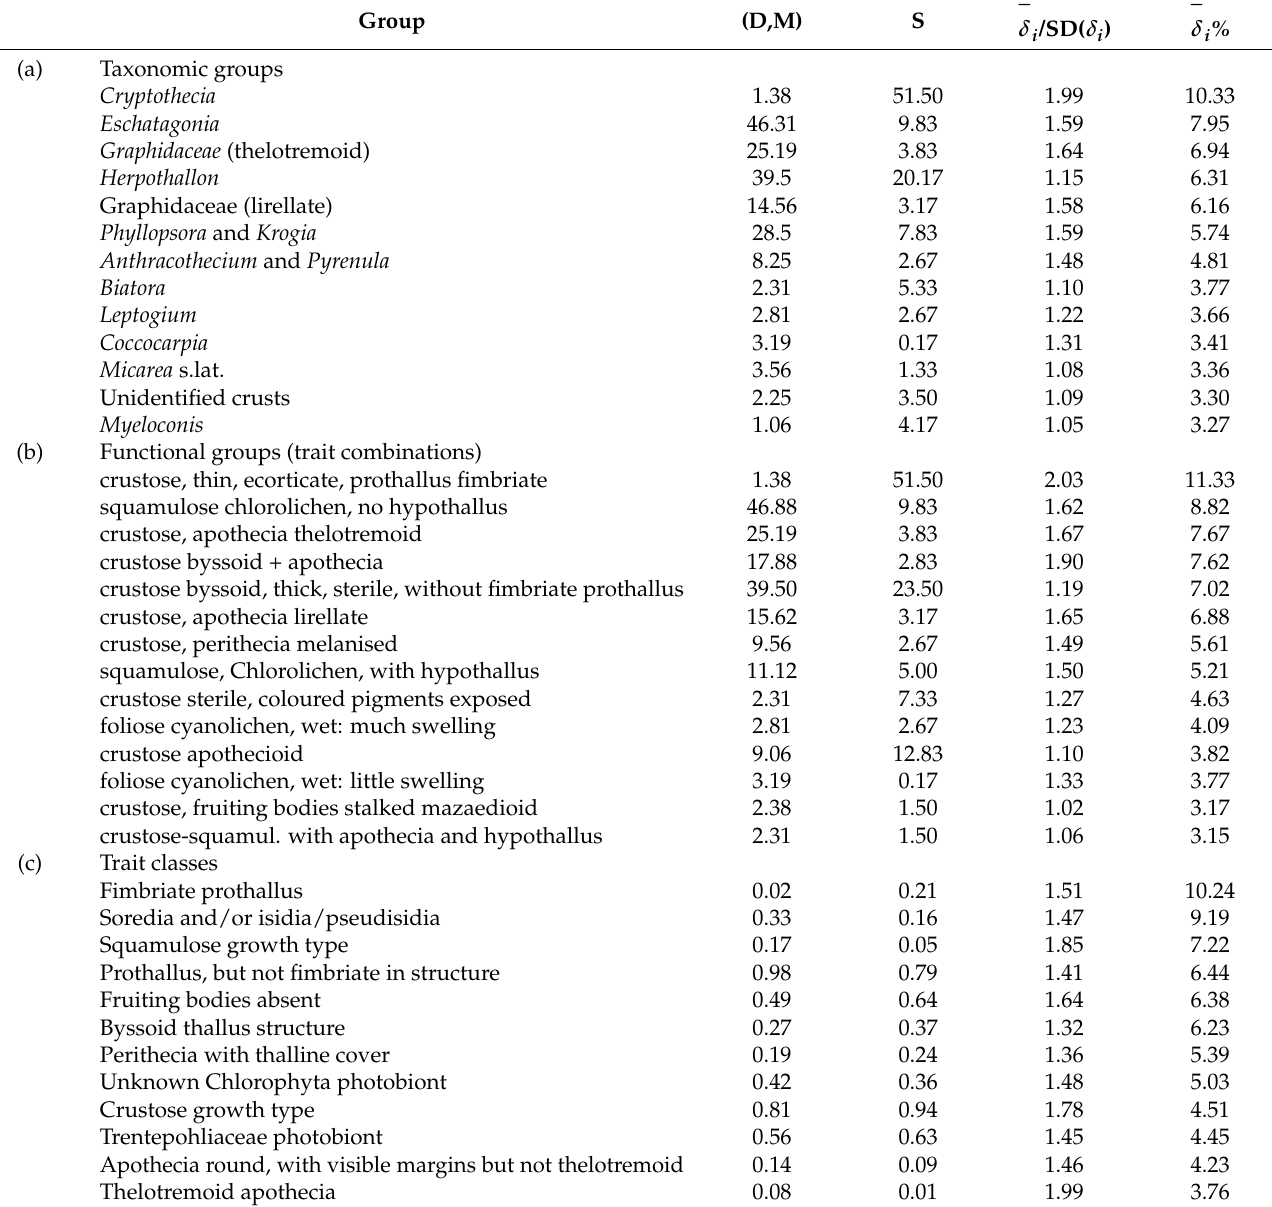
Table 4. Contributions of principal lichen (a) taxonomic groups, (b) functional groups and (c) trait classes to differences in multivariate community structure and trait composition between old growth (Danum [D], Maliau [M]) and logged (SAFE [S]) sites. (D,M), S: overall mean abundance in old growth and logged sites, respectively; δ i /SD ( δ i ) = average group contribution to group dissimilarity divided by standard deviation of contributions; δ i % = percent contribution of group to overall between-group dissimilarity. Only the most important taxa ( δ i % ≥ 3%) are